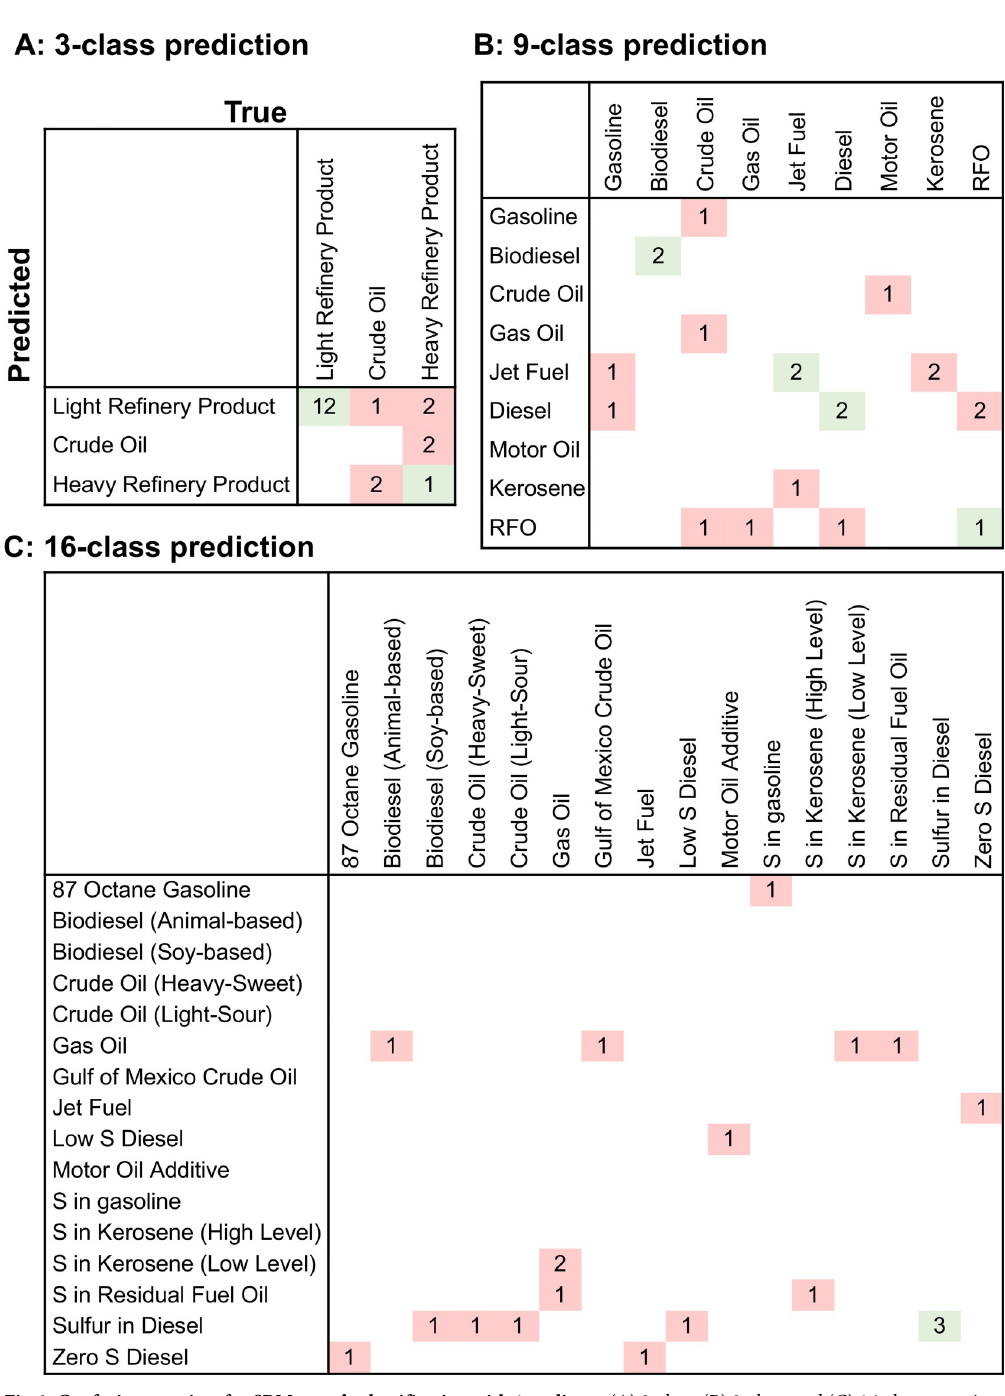
Fig 6. Confusion matrices for SRM sample classification with 1 replicate. (A) 3-class, (B) 9-class, and (C) 16-class